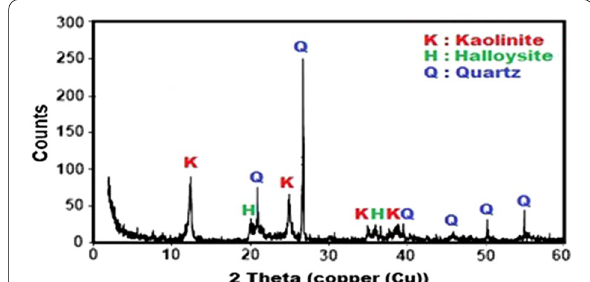
Fig. 4 XRD pattern of the raw clay materials (after El-Maghraby et al.